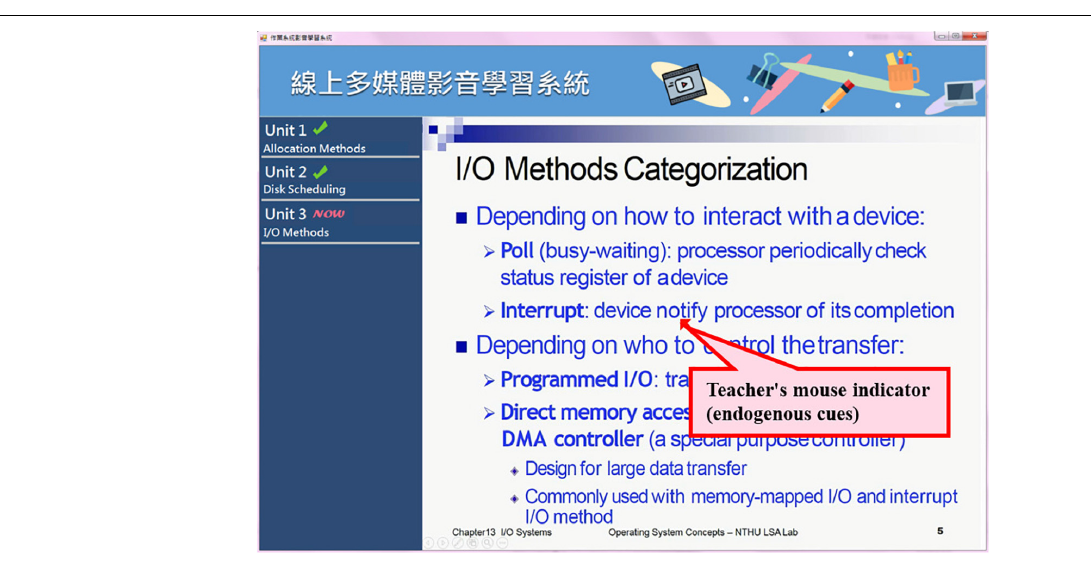
FIGURE 2 | Central cues representing